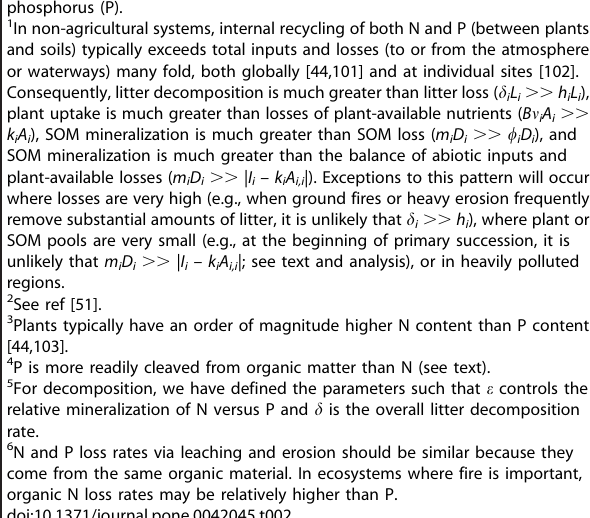
Table notes and references: The subscript i refers to nitrogen (N) and phosphorus